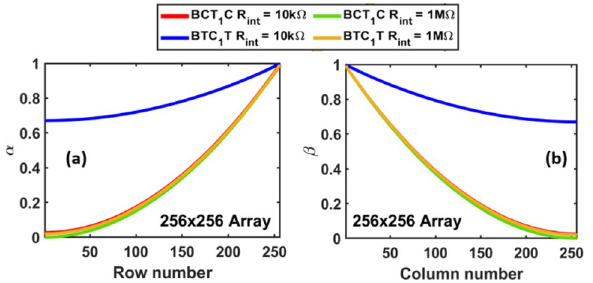
Figure 6. ( a ) Plot of sneak path parameter α as a function of row index. ( b ) Plot of sneak path parameter β as a function of column